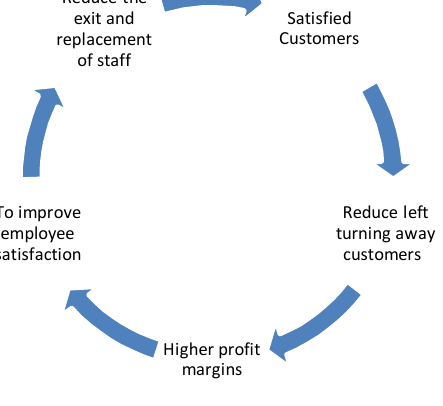
Fig. 2. Optimal service cycle (Khodayari fard,